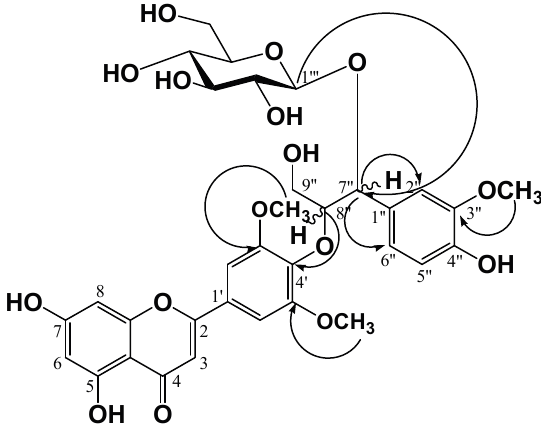
Figure 2. Key HMBC correlations of compound 4